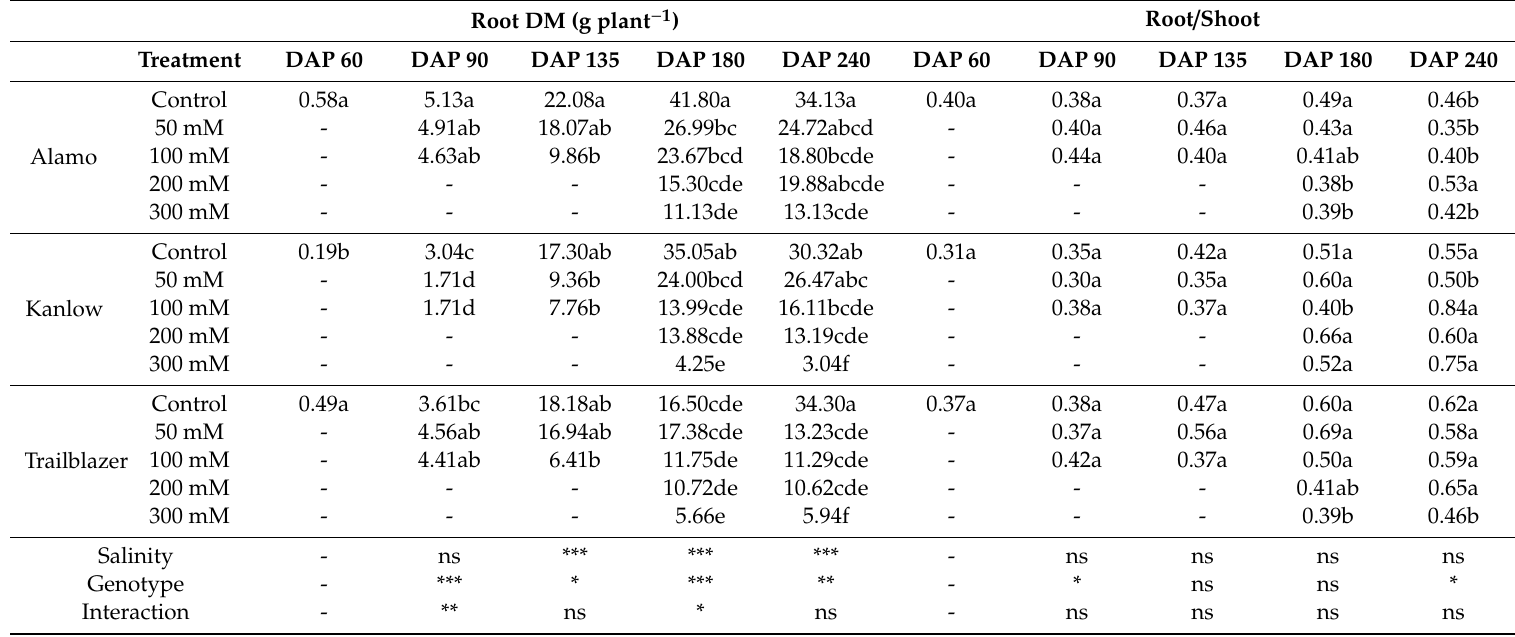
Table 2. The root dry matter (DM) and root to shoot ratio in Panicum virgatum (Alamo, Kanlow and Trailblazer genotypes) for the control, 50, 100, 200 and 300 mM NaCl